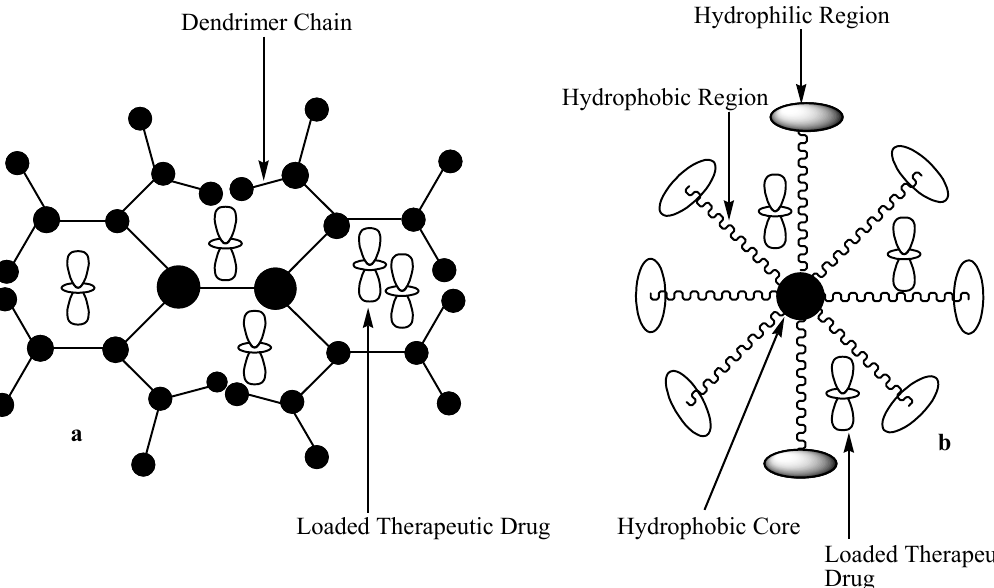
Figure 19. Schematic diagram showing ( a ) dendrimers loaded with drug and ( b ) micelles loaded with drug.